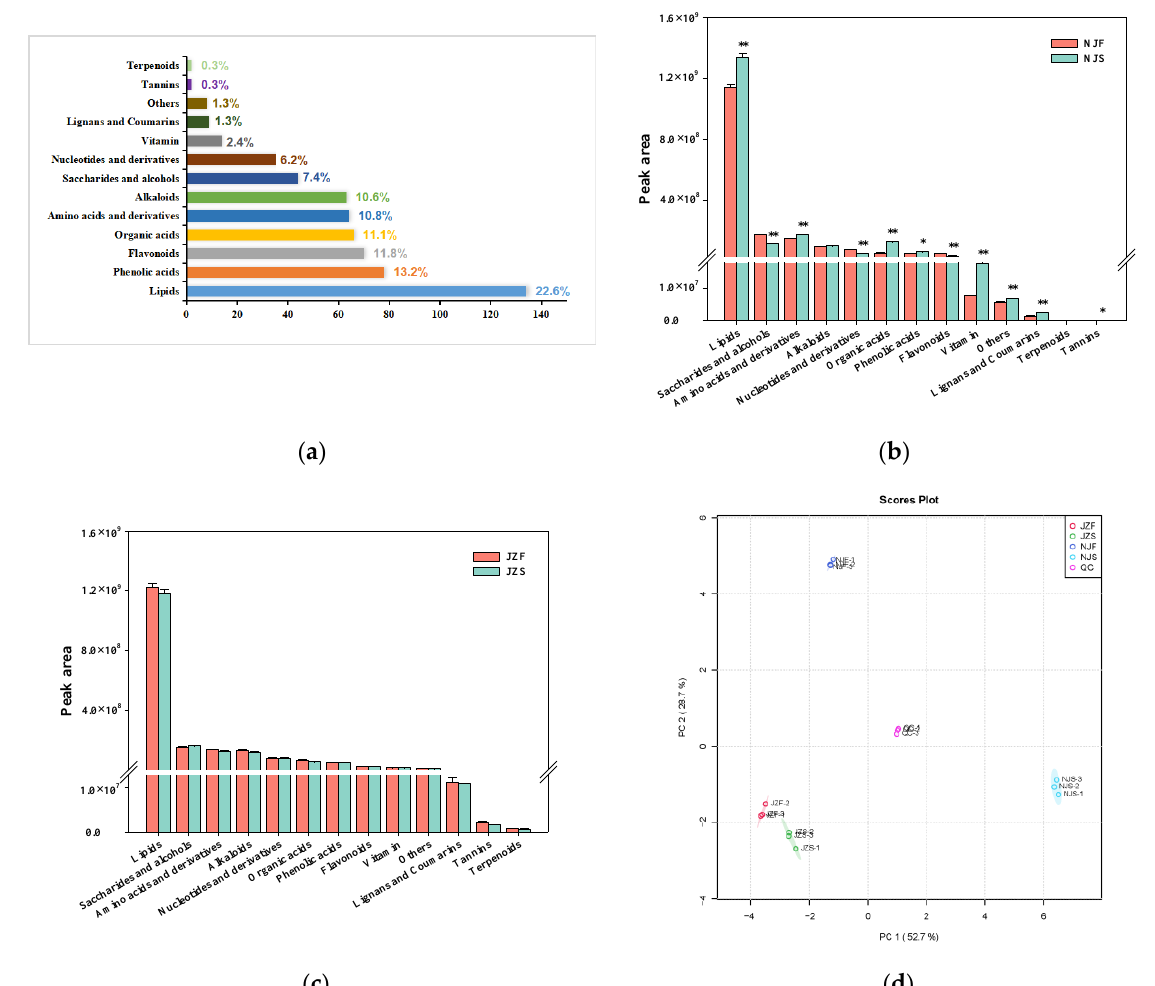
Figure 2. Overview of metabolic profiles. ( a ) Metabolite categories detected in the samples; ( b ) The analyzed peak area comparison in NJ during storage; ( c ) The analyzed peak area comparison in JZ during storage; ( d ) Principal component analysis (PCA) of metabolic profiles in all groups. ( n = 3, *: means the stored group is significantly different compared with the fresh group in the same variety when α = 0.05; **: means the stored group is significantly different compared with the fresh group in the same variety when α = 0.01.)